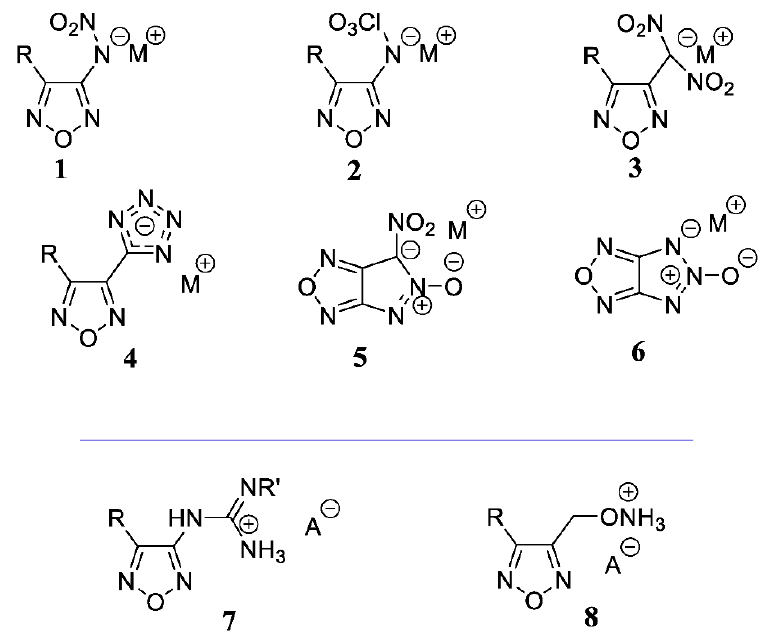
Figure 1. Known energetic furazan-based salts.